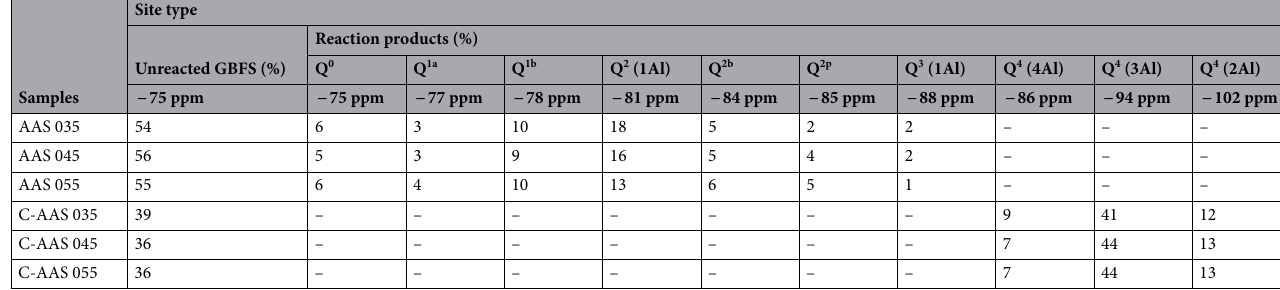
Table 4. Deconvolution of 29 Si MAS NMR results of uncarbonated and carbonated alkali activated slags. The estimated uncertainty in site percentages is ±